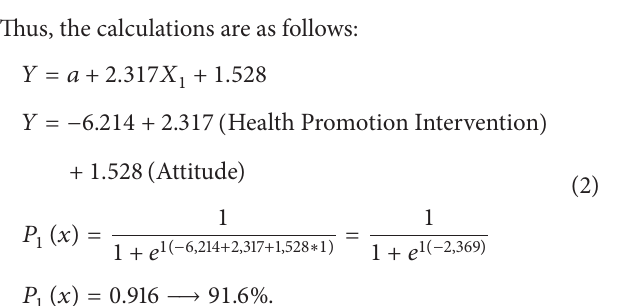
Table 3: Differences in knowledge, positive attitudes, and smoking behavior of staff before and after the interventions. Variable